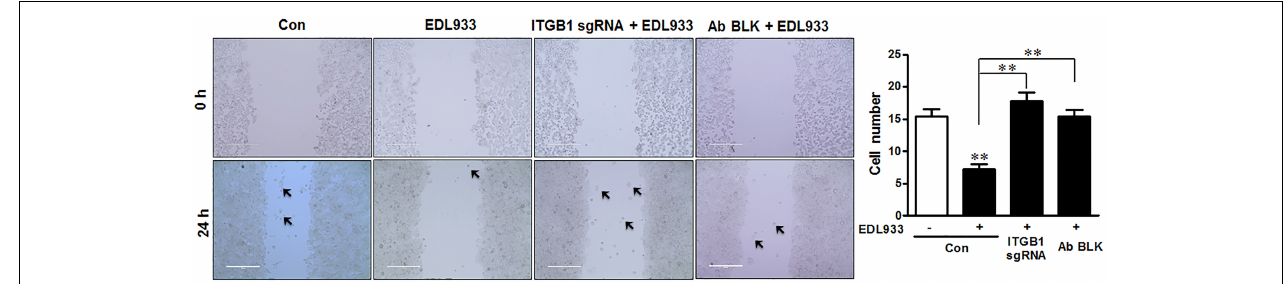
FIGURE 5 | Escherichia coli O157:H7 inhibited cell migration. Caco-2 cell monolayers were scratched and followed by infection with EDL933 strain for 4 h. The migrated cells were counted 24 h post infection at 37 ◦ C. Con, cells without infection; EDL933, cells infected with EDL933 strain. ITGB1 sgRNA + EDL933, integrin β 1 knockout cells infected with EDL933 strain; Ab BLK + EDL933, integrin β 1-blocked cells infected with EDL933 strain. Images were taken at 100 × magnification. Means ± SEM; n = 4. ∗∗ P ≤ 0.01.